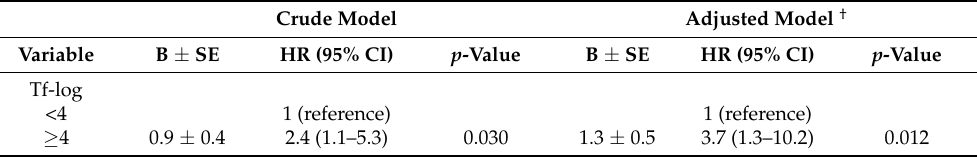
Table 4. Cox’s hazard ratio for the onset of fever according to bacterial counts of T. forthysia . Crude Model